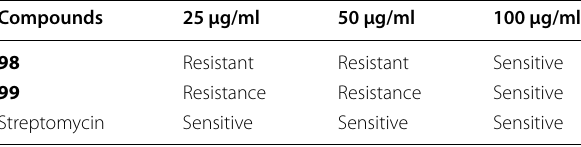
Table 31 Antitubercular activity of synthesized deriva- tives